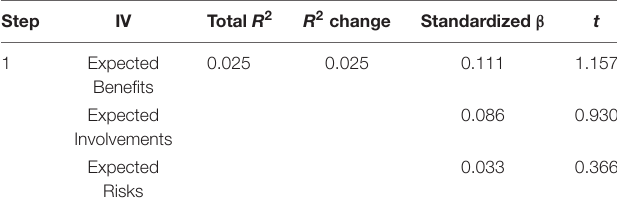
TABLE 6 | Hierarchical regressions predicting cognitive appraisal in risky events variables among victim